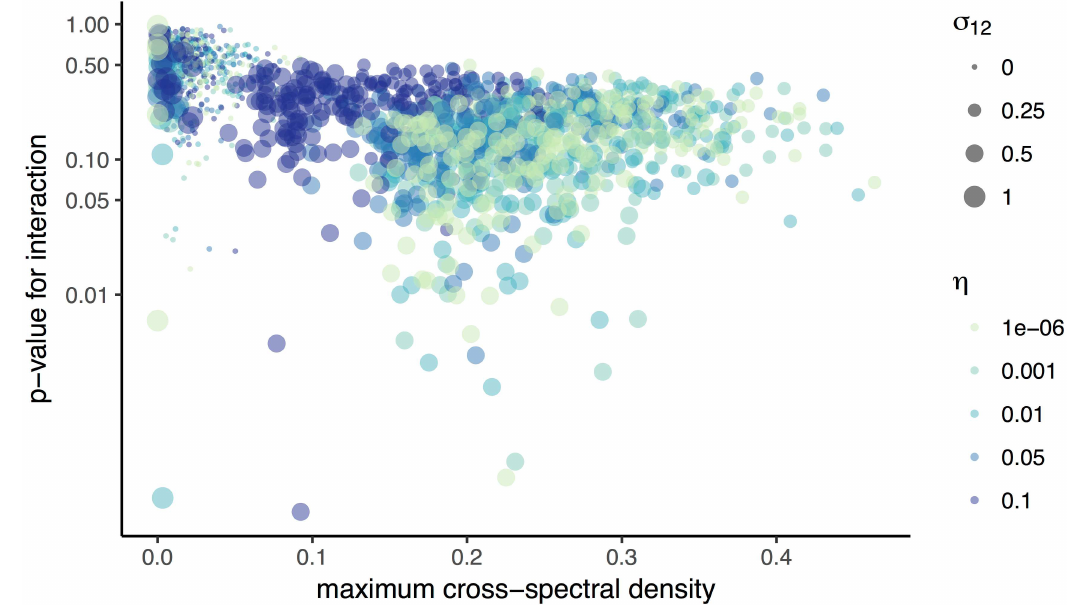
Fig 3. Shared frequency spectrapredict probability of inferred interaction. Points show the maximum cross-spectral densitiesof strains 1 and 2 plotted againstthe p-values for C 1 ! C 2 for 1000 years of annualdata. In all replicates, C 1 never actually drives C 2 . Point color indicatesthe strength of C 2 ! C 1 ( σ 12 ), and point size indicatesthe standard deviation of the process noise ( η ) on